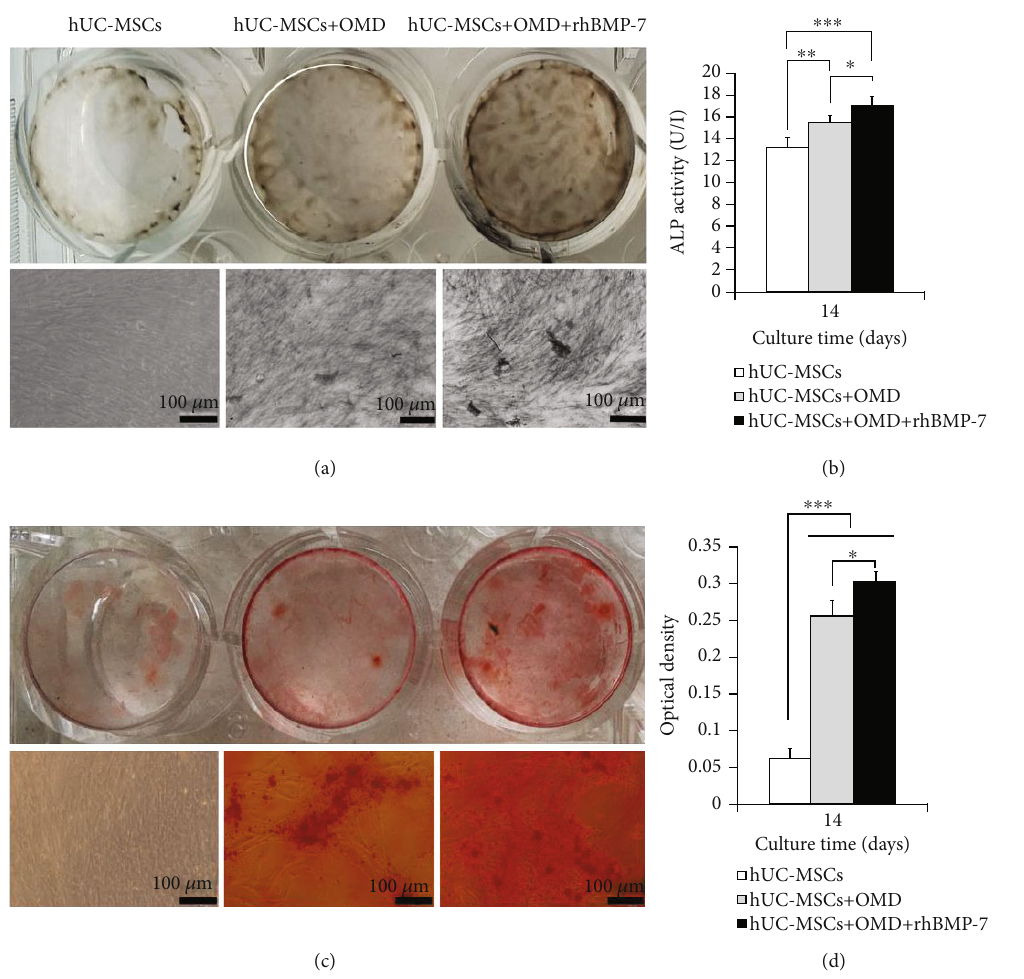
Figure 4: Osteogenic di ff erentiation ability of hUC-MSCs in the in vitro two-dimensional culture microenvironment ( mean ± SD , n = 6 ). (a) ALP staining. (b) ALP secretion. (c) Alizarin red staining. (d) Mineralized matrix formation. Scale bar = 100 μ m . ∗ P < 0 : 05 , ∗∗ P < 0 : 01 , ∗∗∗ P < 0 : 001